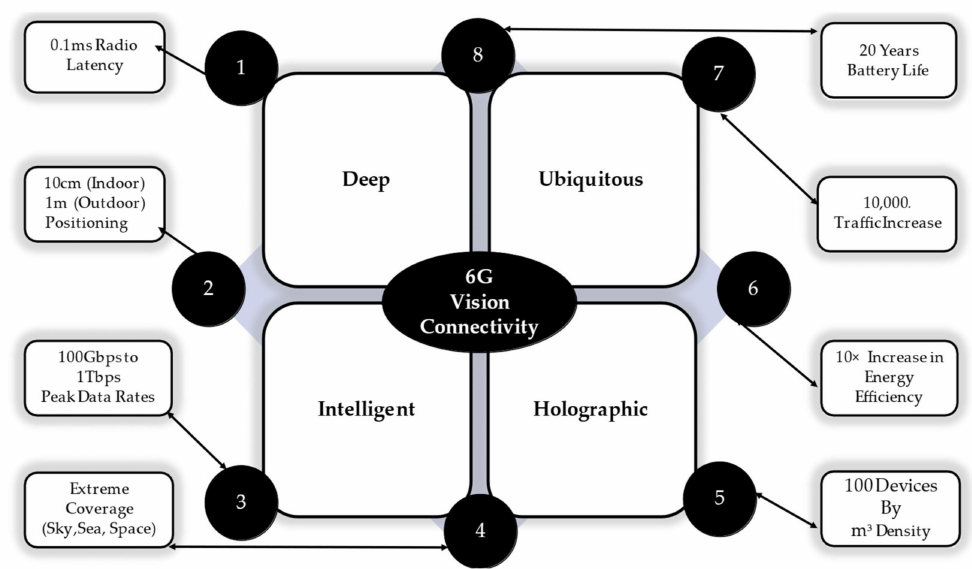
Figure 9. 6G vision